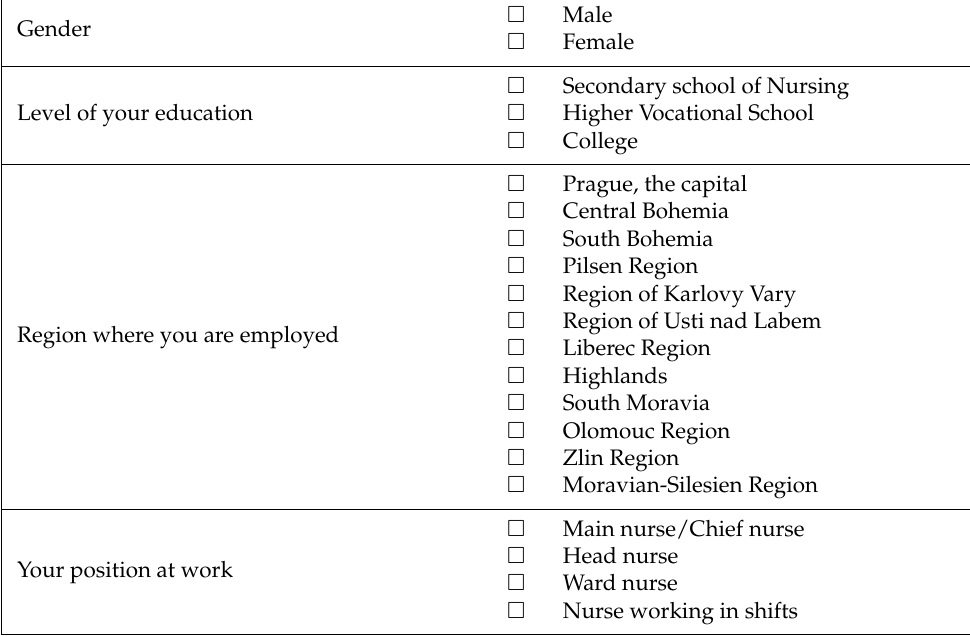
Table A1. Demographical part of Survey.